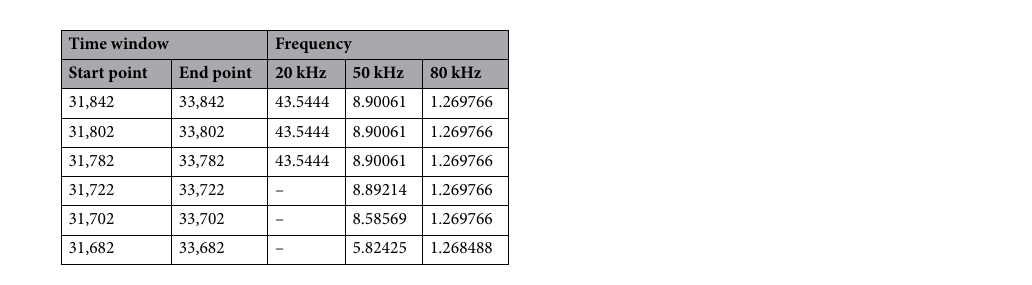
Table 1. S-transform results of signals at different start and end